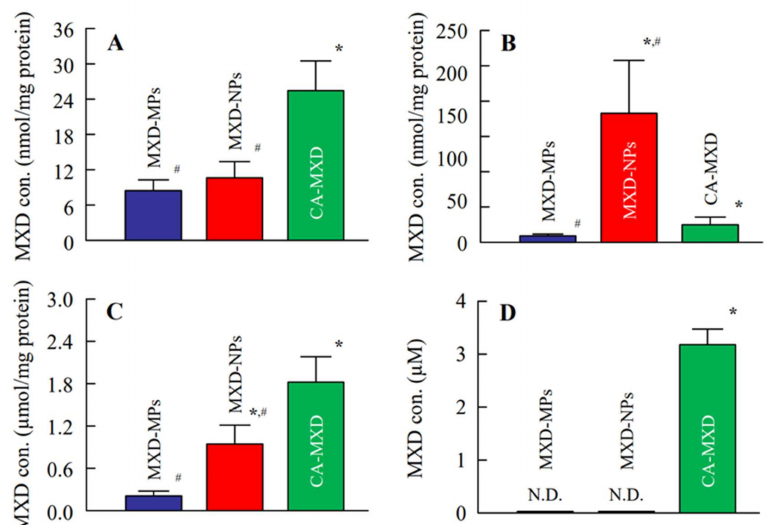
Figure 6. MXD contents in the skin tissue ( A ), hair bulge ( B ), hair bulb ( C ) and blood ( D ) of C57BL/6 mice 4 h after the application of MXD formulations. n = 4–12. MXD-MPs, MXD-MPs-applied mice. MXD-NPs, MXD-NPs-applied mice. CA-MXD, CA-MXD-applied mice. N.D., not detectable.